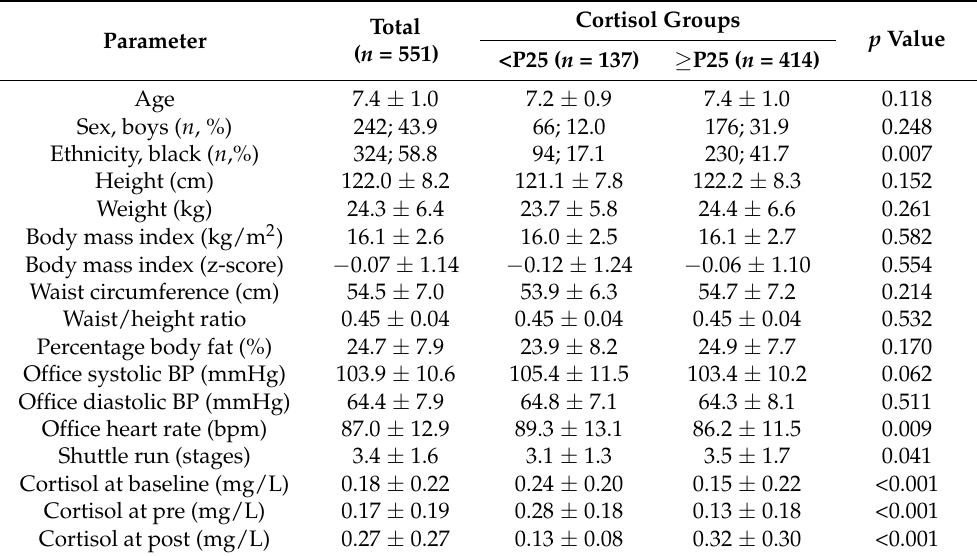
Table 1. Population characteristics of the study at baseline, according to under and upper cortisol reactivity